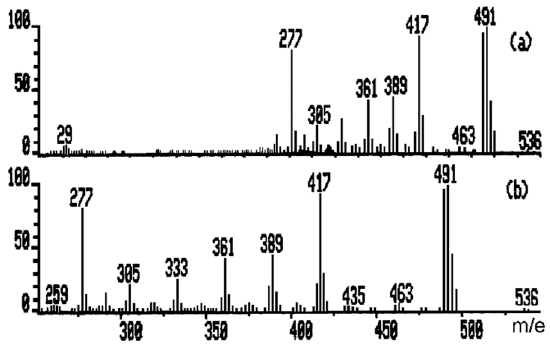
Figure 2. Mass spectrum of octaethoxycyclotetrasiloxane (integral spectrum and 250–540